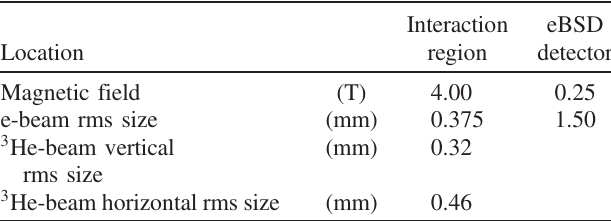
TABLE I. Beam parameters during the 3 He